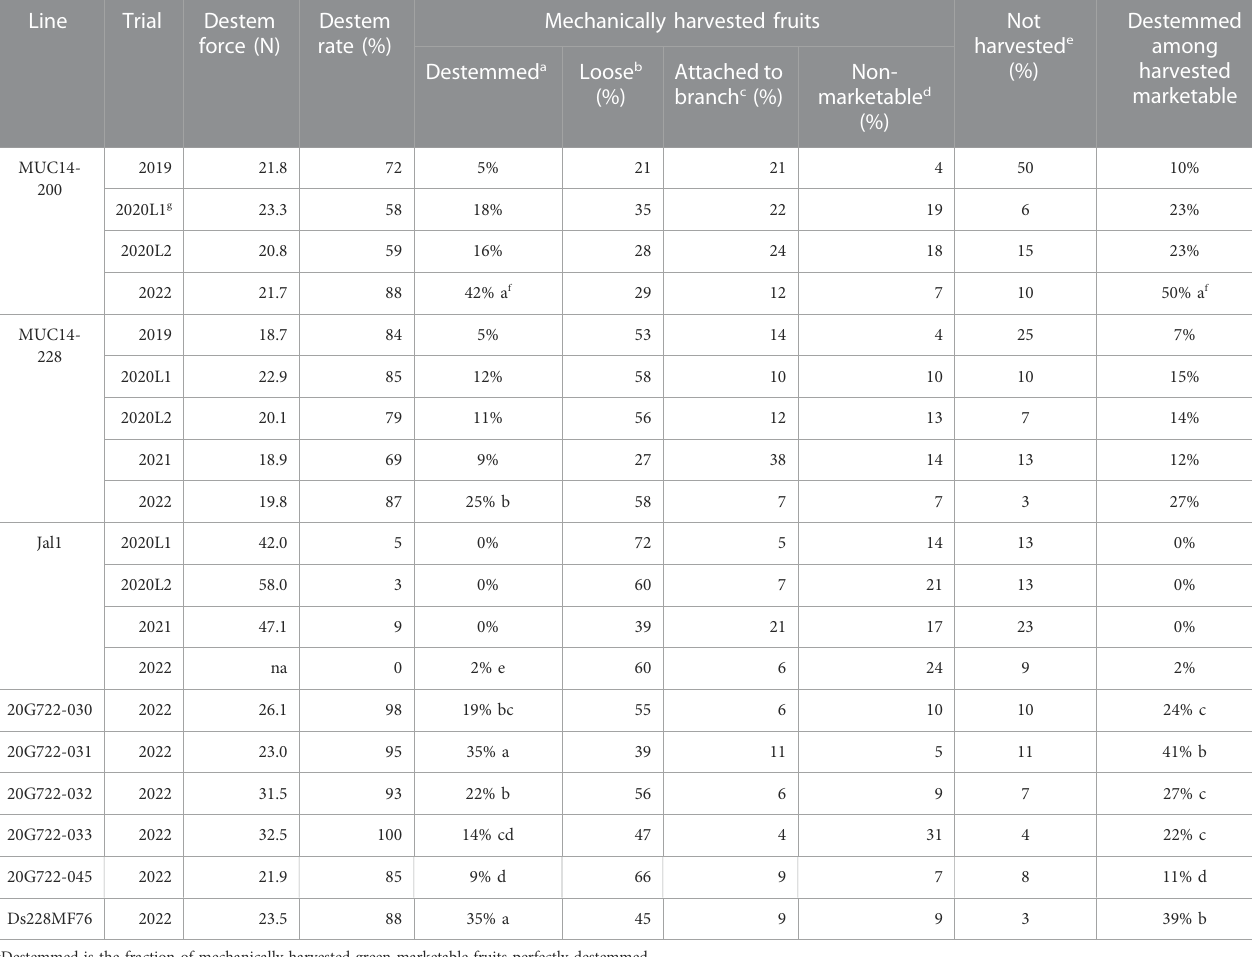
within the destem2.1, 3.2, 4.1, 4.2, and 9.1 QTL regions (Supplementary Table S3). Five of the seven genes are homologs of Arabidopsis genes involved in the receptor kinase signal transduction pathway that activates fl oral organ abscission (Jinn et al., 2000; Butenko et al., 2003). Four of these genes encode receptor-like kinases (RLKs) that interact at the plasma membrane, including HSL2 (dstem2.1), SERK1 (dstem4.2), EVR (dstem3.2) and CST (dstem4.1), to regulate abscission in Arabidopsis (Figure 5) (Cho et al., 2008; Leslie et al., 2010; Lewis et al., 2010; Burr et al., 2011; Liljegren, 2012; Meng et al., 2016). One gene encodes a MITOGEN- ACTIVATED PROTEIN KINASE KINASE5 (MKK5) that is involved in transducing the signal downstream of the membrane associated RLKs in Arabidopsis (Cho et al., 2008). These data suggest that changes in key components of the abscission signal transduction pathway may be responsible for the early activation of the pedicel/fruit abscission zone and that these genes may regulate easy-destemming in UCD14- derived lines of